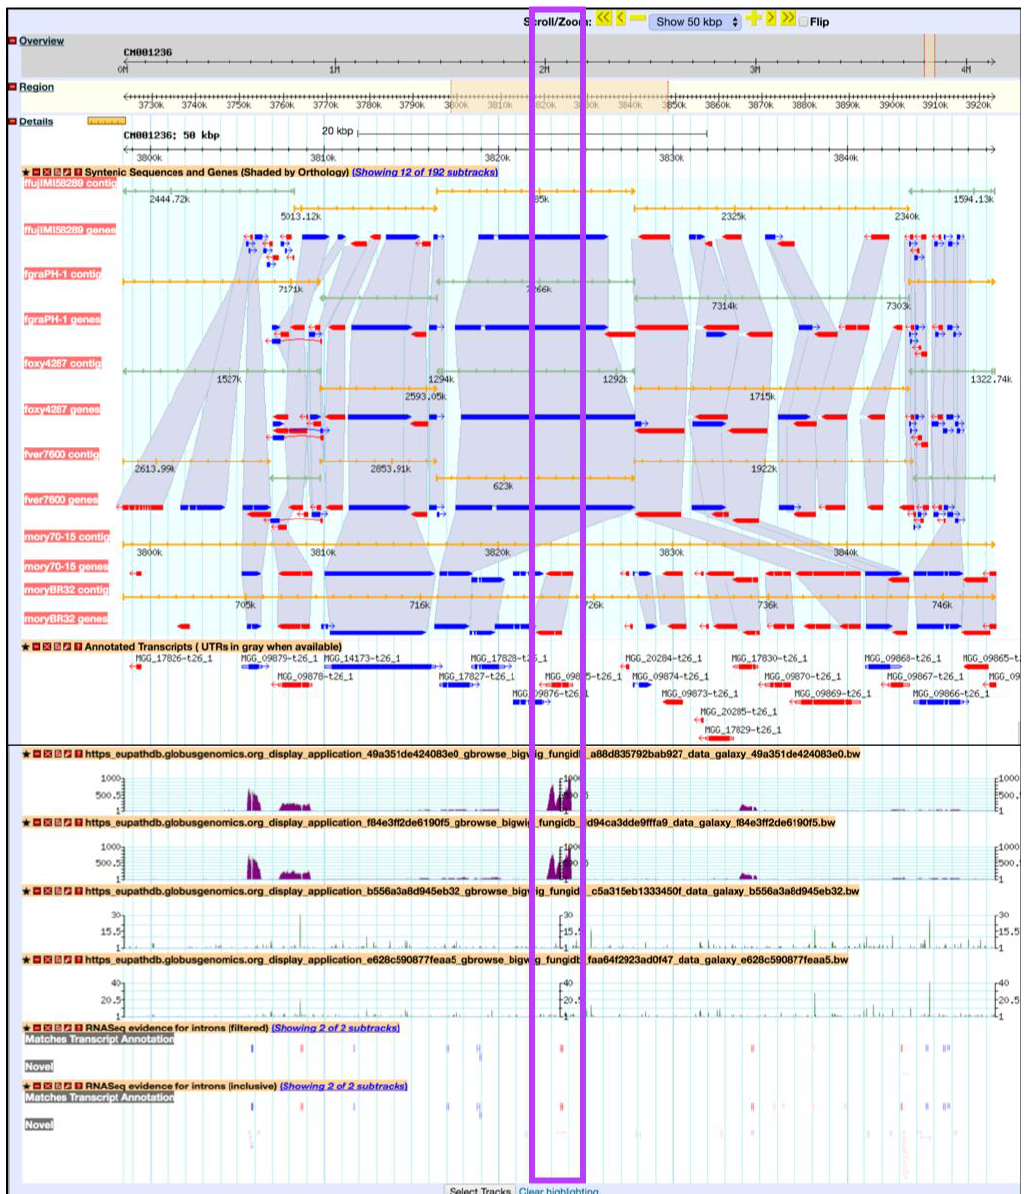
Figure 19. Viewing BigWig files in the FungiDB GBrowse. Shown are synteny tracks for selected Sordariomycetes (highlighted in purple). Tracks can be activated from the Orthology and synteny section, which is located under the Select Tracks tab.